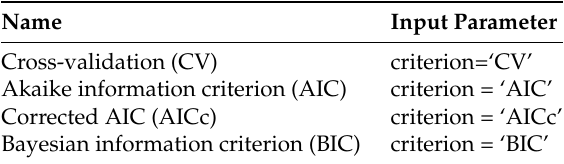
Table 4. Different model fit